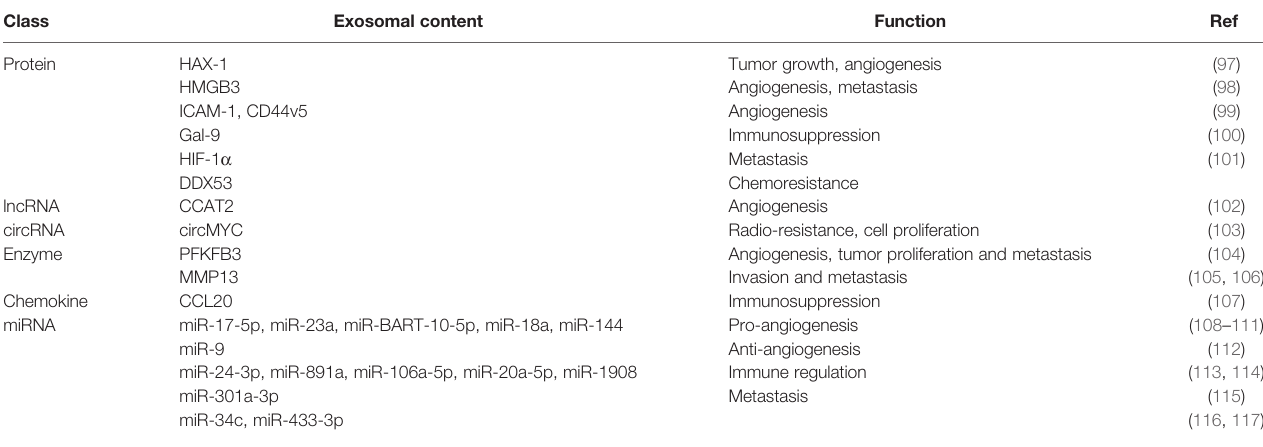
TABLE 1 | Exosomal content and their